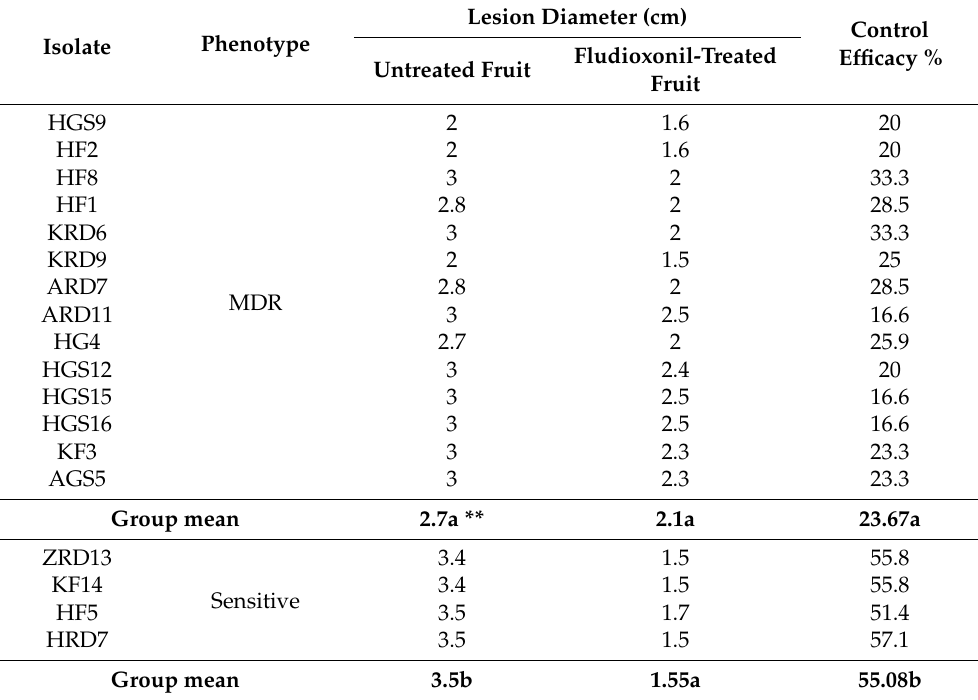
Table 1. Aggressiveness, in terms of lesion diameter (cm), of Penicillium expansum MDR and sensitive isolates on fludioxonil-treated or untreated apple fruit (cv. Red Delicious), 7 days post inoculation. Lesion Diameter (cm) Isolate Phenotype